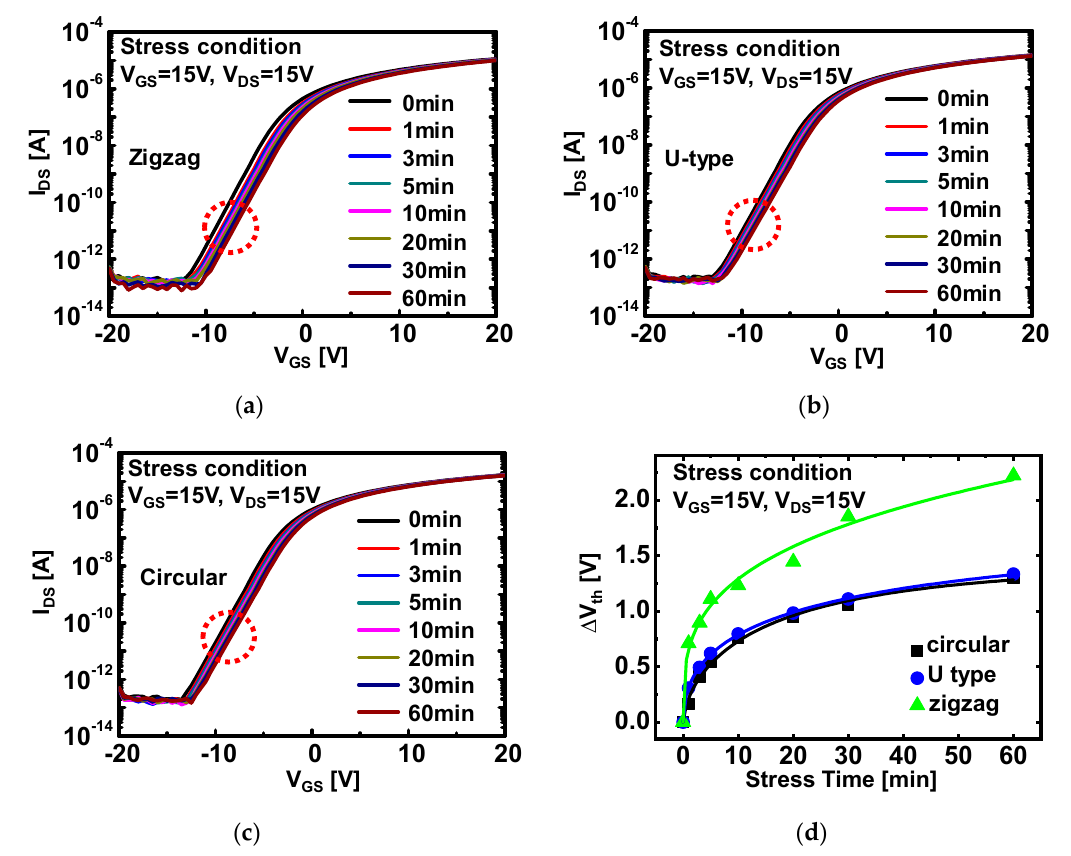
Figure 4. Transfer characteristics of ( a ) zigzag, ( b ) U-type, and ( c ) circular a-IGZO TFTs under bias stress condition of V GS = 15 V and V DS = 15 V. All of the bias stress tests were executed under 60 ℃ substrate temperature for 60 min. ( d ) Evolutions of threshold voltage shift depending on bias stress time under stress condition of V GS = 15 V and V DS = 15 V. Table 1. Summary of ∆ V th and trapping time extracted from stretched exponential equation for 3- types a-IGZO TFTs.